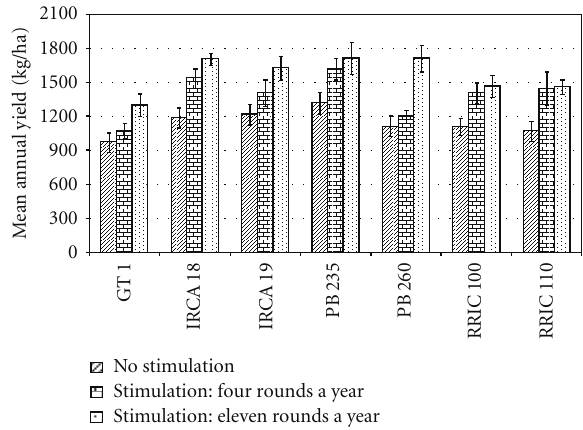
Figure 2: Clonal variations in annual fields for the various clones. Vertical bars represent standard errors of means (SEM) for each clone and treatment.